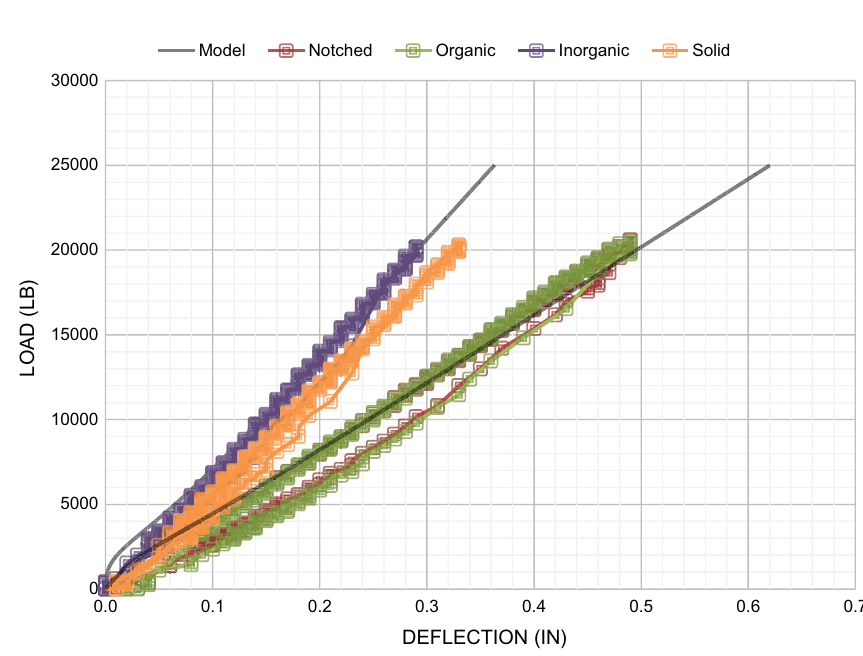
Fig. 15 Full-scale beam comparison.